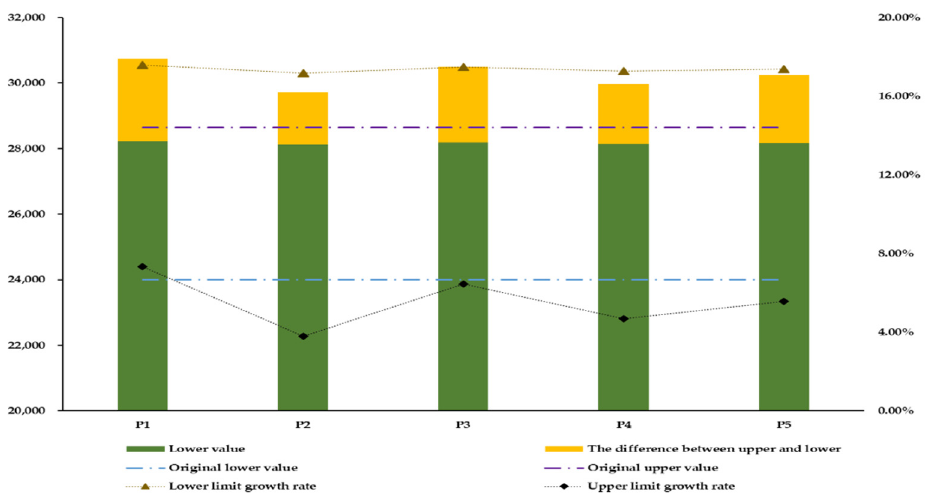
Figure 4. Optimization of the downstream region of Tingjiang River for the eco-compensation allocation of Guangdong Province ( × 10 4 CNY). Table 5. Eco-compensation allocation of the downstream administrative units under different hy- drological scenarios based on the IFTS model (lower limit).